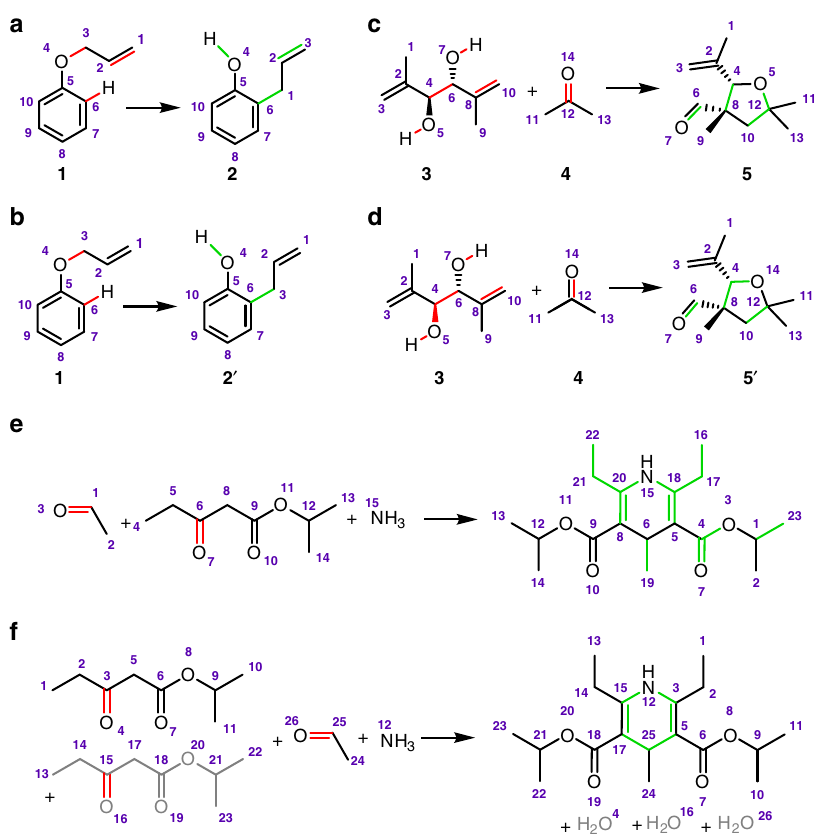
Fig. 1 Examples of problems encountered by traditional matching algorithms. a , b The number of bonds being cut might not necessarily be minimal. The example shown here is for a (sigmatropic) Claisen rearrangement 1 . The mapping in ( a ) is correct, even though the one in ( b ) entails fewer bonds being cut (bonds that are disconnected are colored in red whereas bonds created are marked green). c , d Several alternative mappings with the same “ bonds-cut ” score might exist. Shown here are two alternative mappings of Prins rearrangement 39 — in both cases, six bonds are being cut and four are formed. The correct mapping, one determined by our algorithm, is shown in ( c ). e , f When chemists write organic reactions, they usually do not account for full stoichiometry. The example here is for the Hantzsch dihydropyridine synthesis 40 in which only one molecule of ketoester would typically be provided in a synthetic scheme. e Competitive mappers do not account for the missing substrate and either yield incorrect mapping (as shown here based on Marvin 33 ) or fi nd no mapping at all (Baldi ’ s ReactionMap 32 ). f Our method considers missing atoms or substrates (here, one with bonds colored gray) and maps the reaction